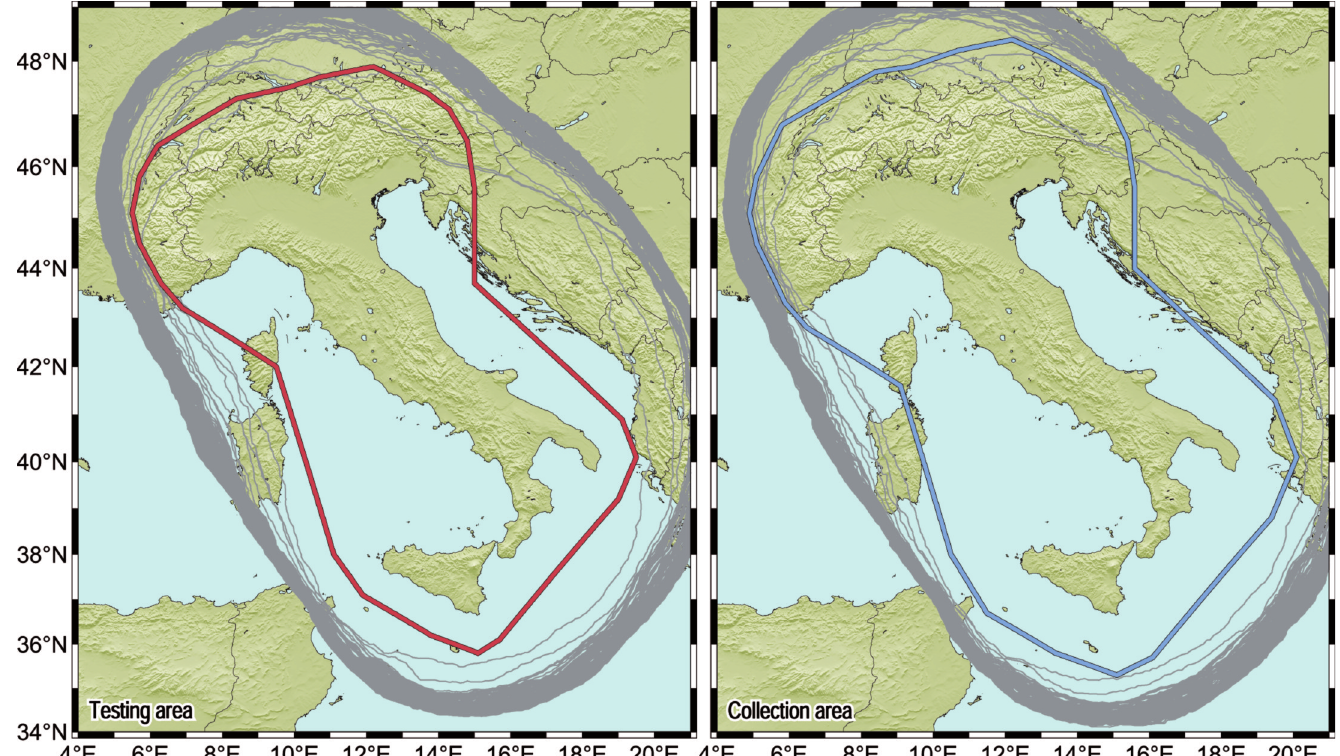
Figure 3. INGV network detection capabilities over time. For each region the corresponding detection probabilities for each day in the period April 16, 2005 to January 1, 2008 are shown as 991 contour lines. (Left) Testing area is shown in red and contour lines show the P (Right) Collection area is shown in blue and contour lines show the P